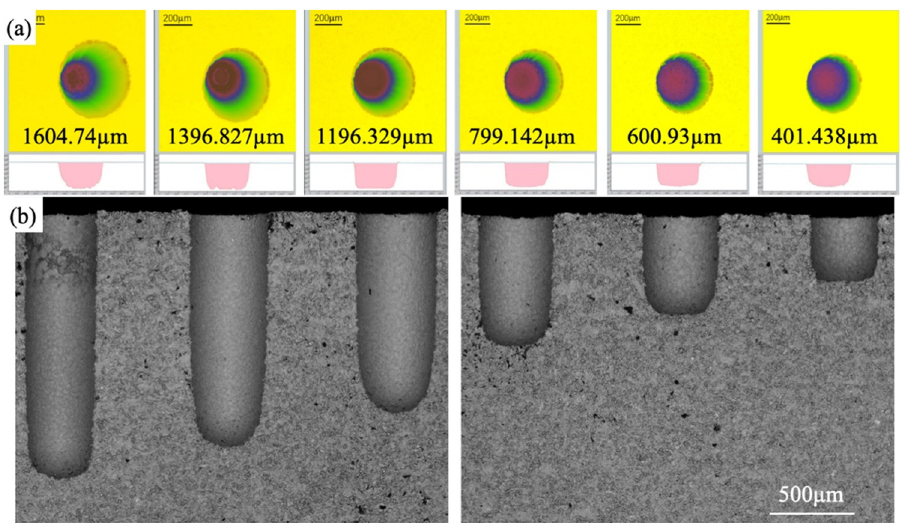
Figure 11: Blind holes processed by copper electrode: ( a ) the 3D morphology; ( b ) the SEM image ( frequency = 130 kHz, pulse width = 5 µs, electric current = 4.5, voltage = 90 V, gain coe ffi cient = 30 )